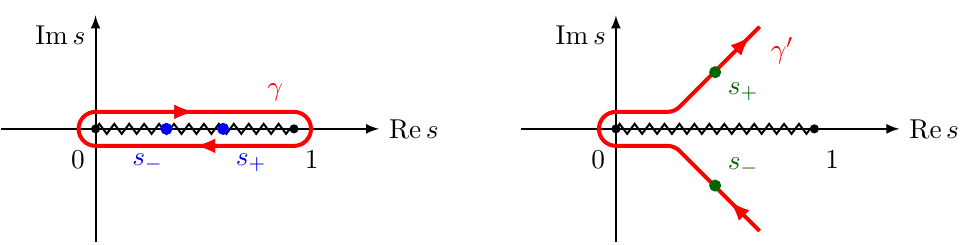
Figure 3 . On the left, the integration contour for the original integral in (6.2). This choice is particularly convenient for α > α w , where both saddles are real (blue dots). On the right, the deformed contour is associated with the steepest descent approximation for α < α w , where both saddles are complex (green